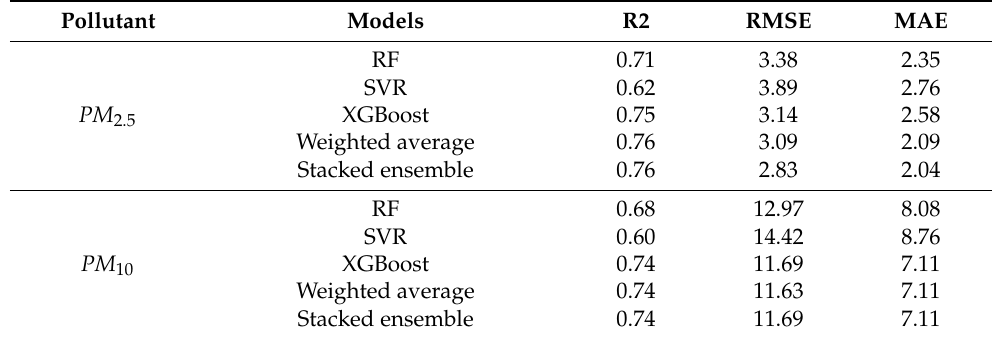
Table 6. Comparison of forecasting models evaluation results based on satellite data (created by author).